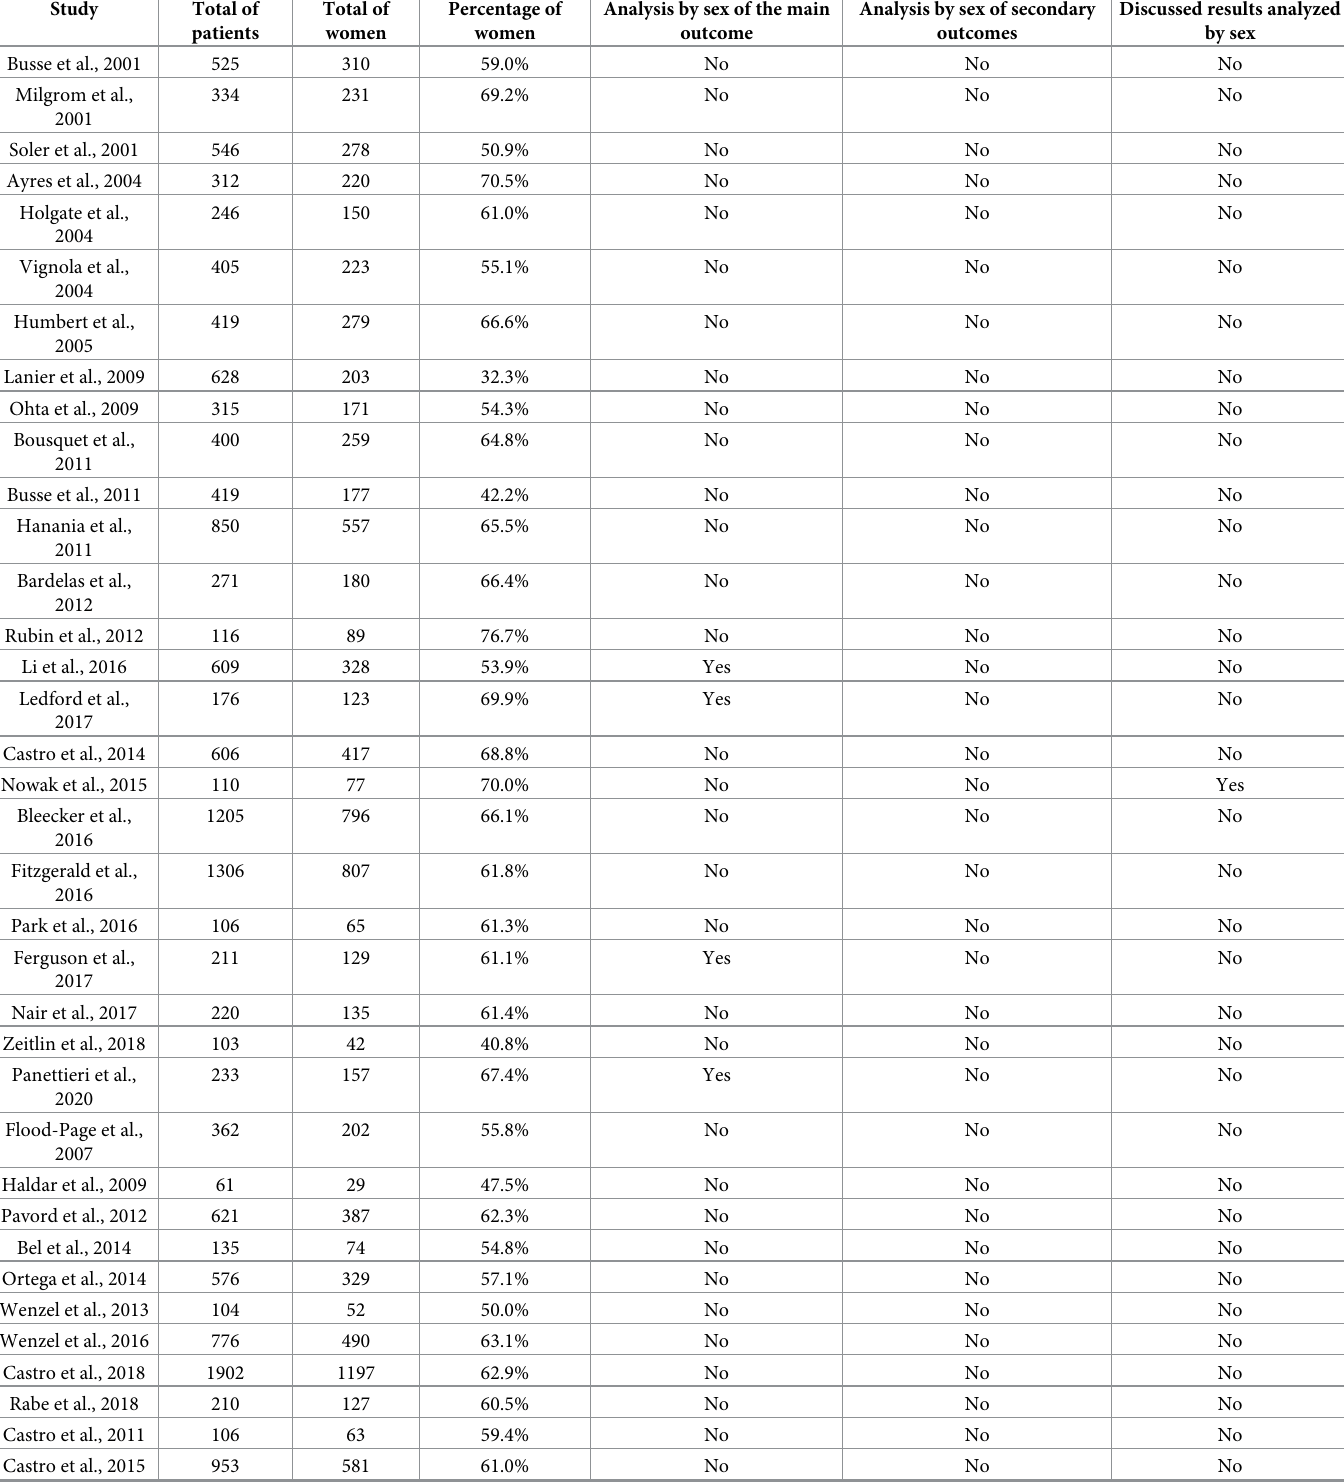
Table 3. Proportion of women and other characteristics of sex assessment. Study Analysis by sex of secondary